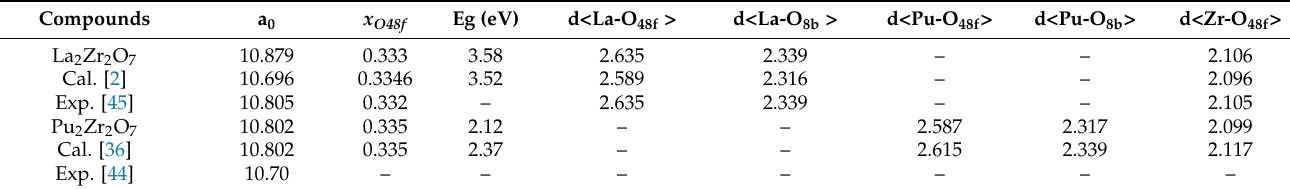
( b ) Figure 2. Variation of ( a ) temperature and ( b ) total energy with time for La 2 Zr 2 O 7 with 0.3% electron excitation. To investigate how the electronic excitation concentration affects microstructural evolution in La 2 Zr 2 O 7 at 300 K, electronic excitation concentration of 0.3%, 0.6%, 1.2%, and 1.6% are considered. Based on each equilibrium state, the radial distribution function (RDF) analysis is then carried out. Figure 3 shows the RDF for La 2 Zr 2 O 7 with 0.3%, 0.6%, 1.2%, and 1.6% electronic excitations. For electronic excitations of 0.3%, 0.6%, and 1.2%, it